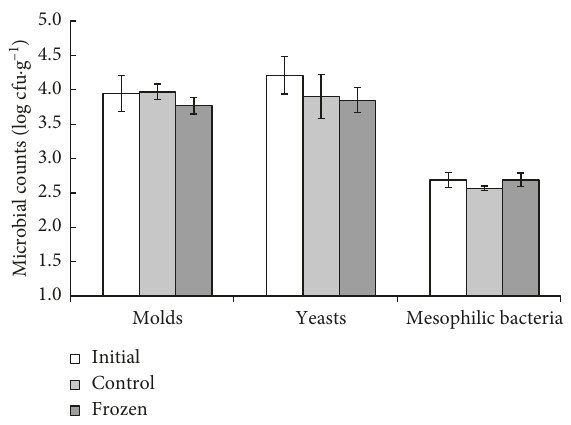
Figure 1: Microbial counts of Deglet Noor date fruits on control or frozen treatment. Data are expressed as means ( n � 3) ±